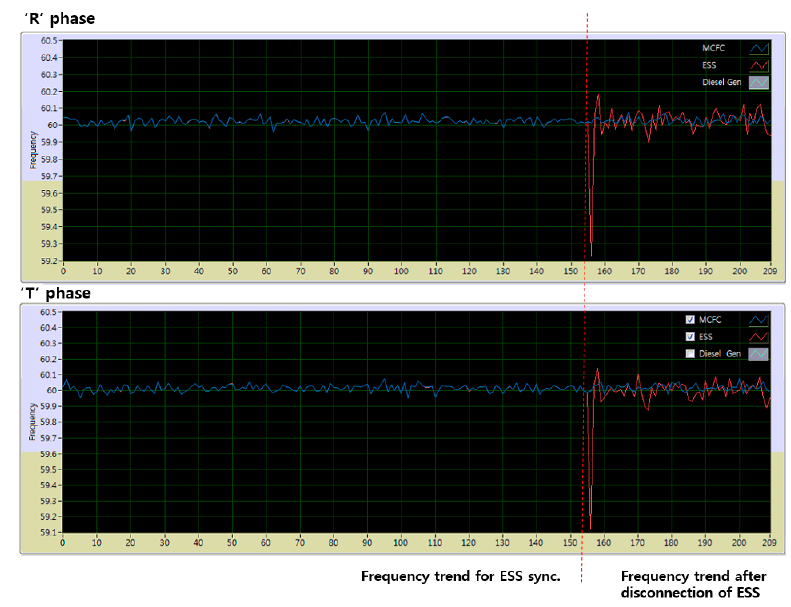
Figure 19. Frequency change in ESS system deviation.